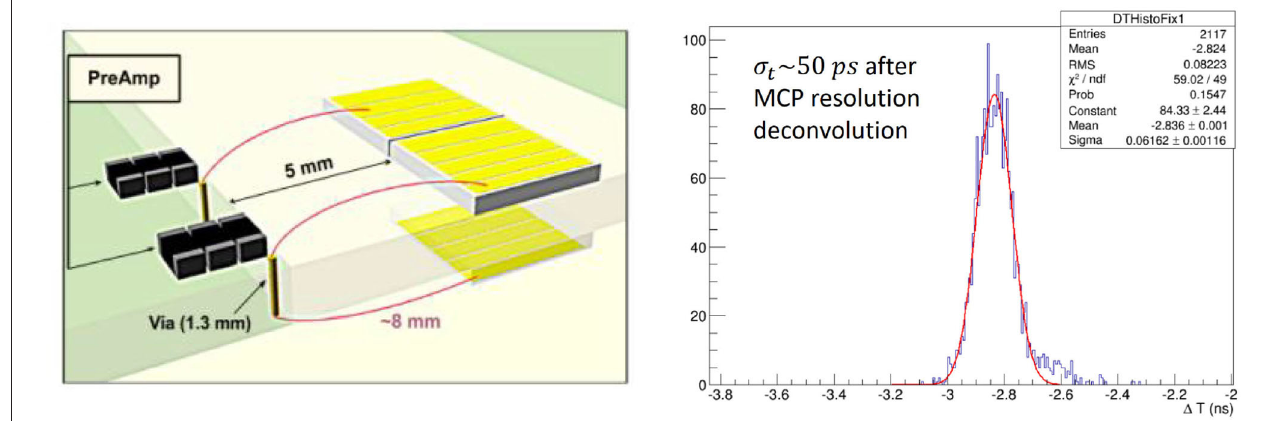
FIGURE 10 | On the left, a scheme of the DD architecture, with corresponding strips on both sides connected to the same amplification input. On the right, time difference distribution between a DD plane and a reference Microchannel Plate photomultiplier tube (MCP-PMT). Adapted from Berretti et al. [54] under the Creative Commons CC BY